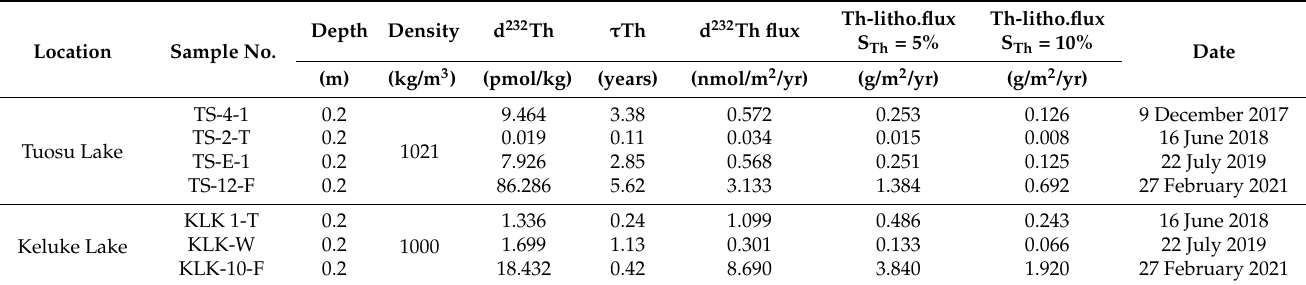
Table 6. Seasonal changes in dissolved 232 Th flux and lithogenic flux in Tuosu Lake and Keluke Lake.